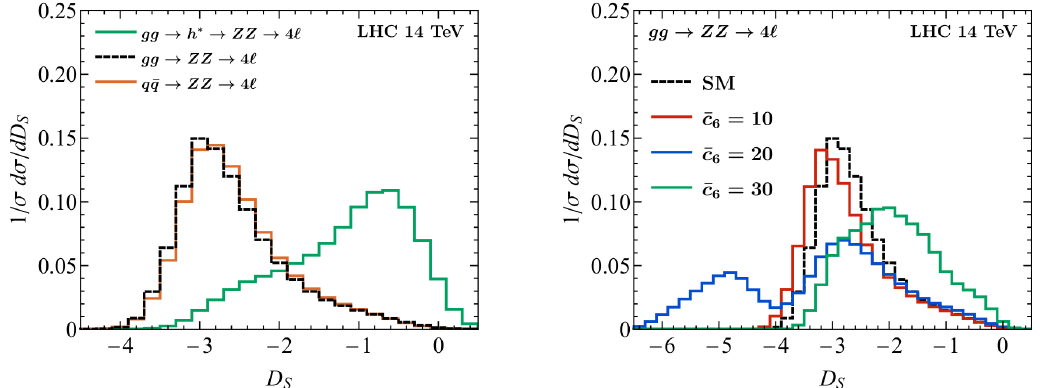
Figure 4. Left: normalised D S distributions in the SM for the Higgs signal (solid green), all gg -initiated channels combined (dashed black) and the q ¯ q -initiated background (solid orange). Right: normalised D S distributions for the gg -initiated contributions in the SM (dashed black) and for ¯ c 6 = 10 (solid red), ¯ c 6 = 20 (solid blue) and ¯ c 6 = 30 (solid green). See the main text for further